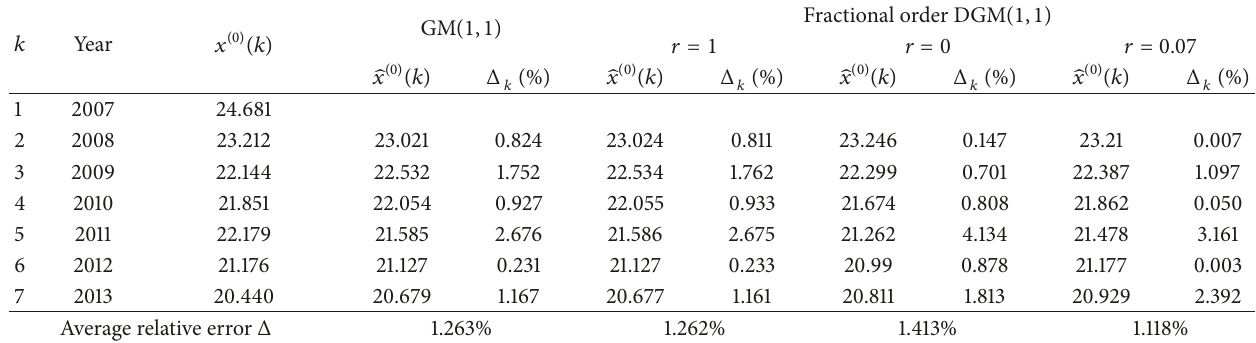
Table 5: Fitting accuracy of China’s sulfur dioxide emissions (unit: million tons).